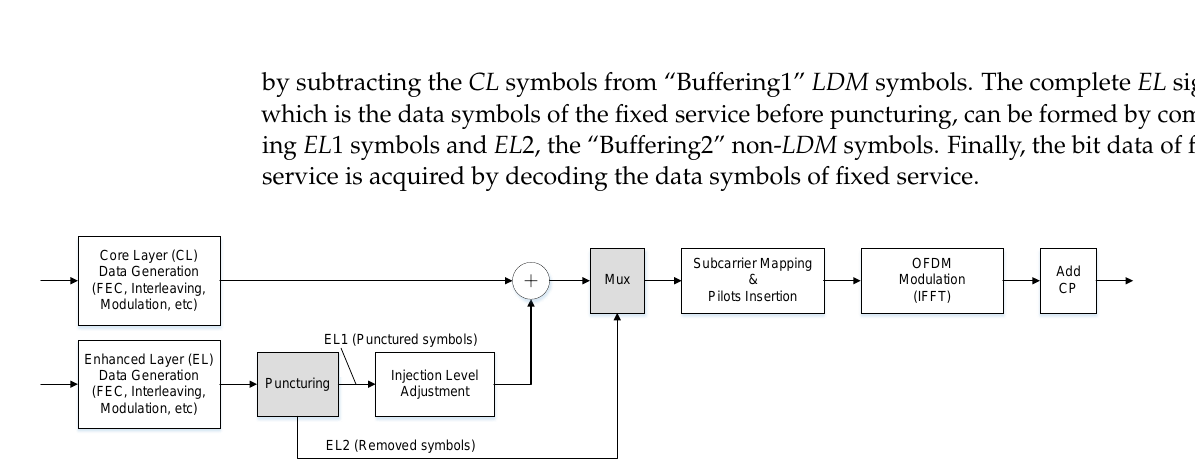
Figure 2. The transmitter structure of the layered division multiplexing extension frequency-division multiplexing (LDM- Ex-FDM) scheme.